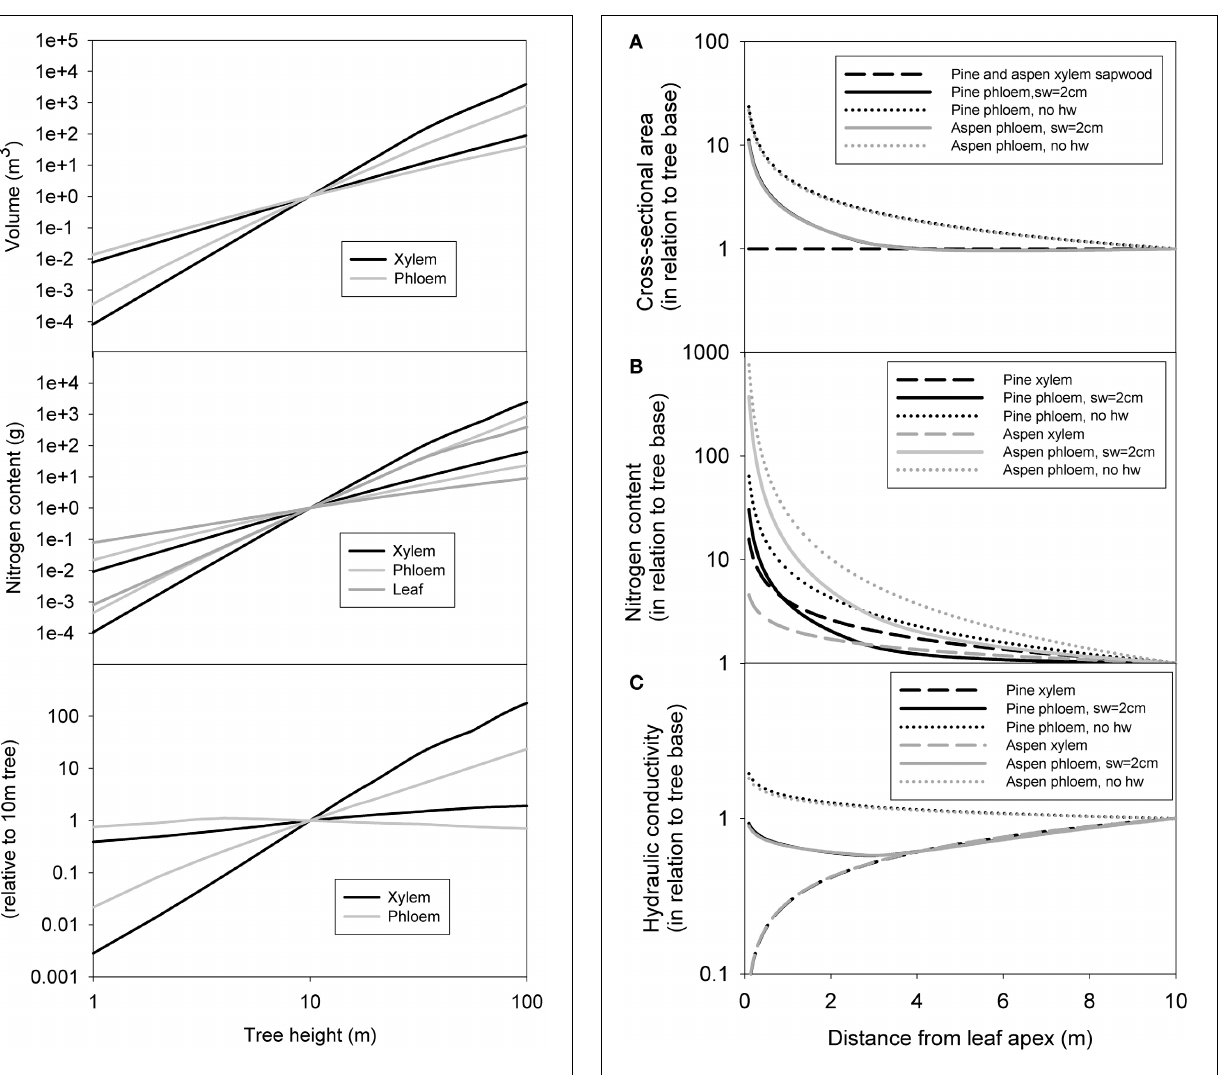
FIGURE 7 | The axial distribution of xylem sapwood and phloem cross-sectional area (A), nitrogen content (B) and hydraulic conductivity in a 10-m tree (C). Values are expressed in relation to tree base in each case. “sw = 2cm” refers to a scenario where maximum sapwood depth was assumed to be 2cm, and “no hw” refers to a scenario of no heartwood formation, i.e., all of the xylem was assumed to be